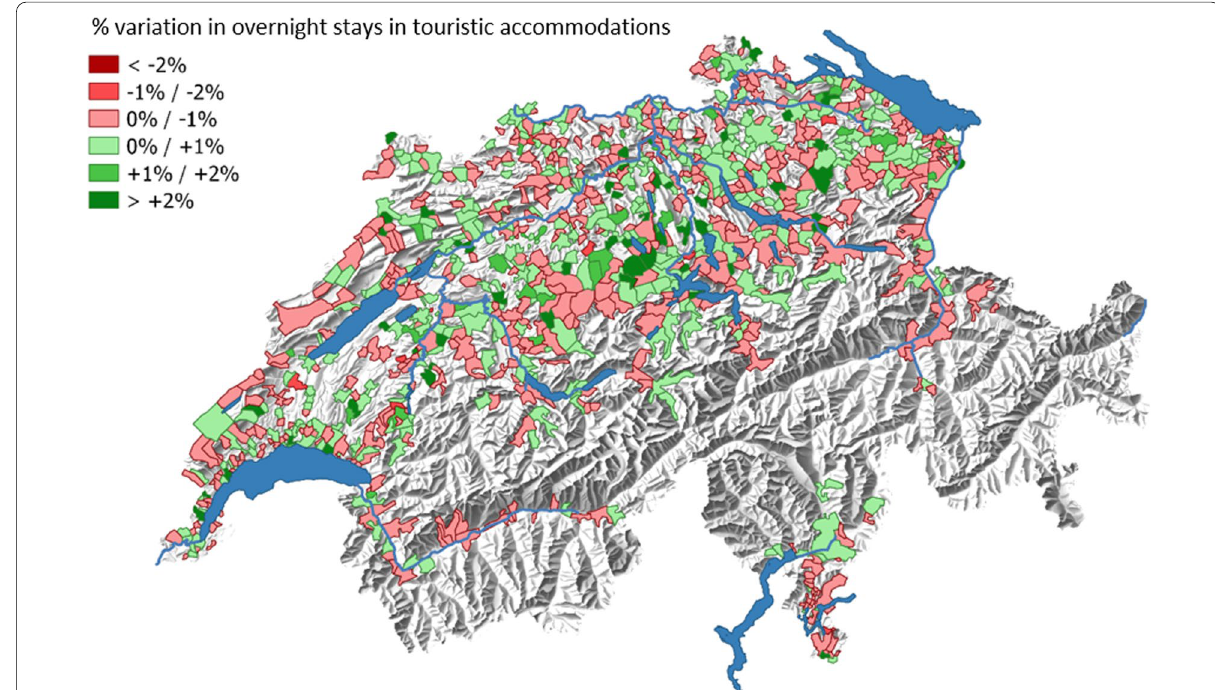
Fig. 7 Not restricted to new second home construction municipalities: Variation in percentage of touristic overnight stays in managed accommodations. Source : Author’s illustration of data from the FSO Tourist accommodation